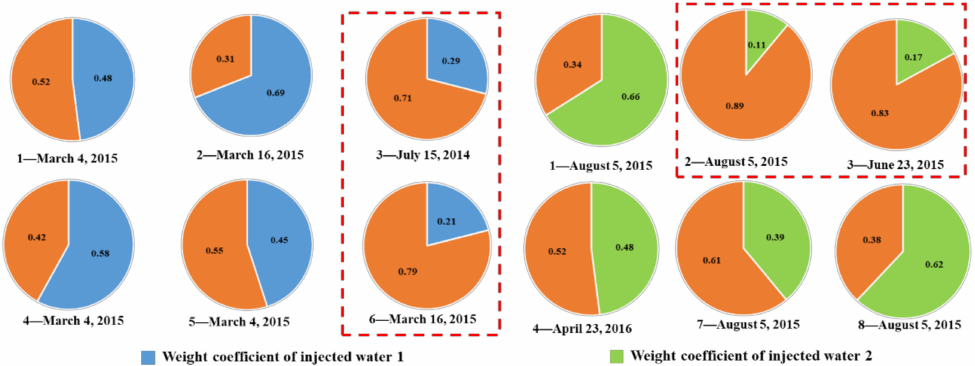
Figure 2. Source proportions of produced water in block